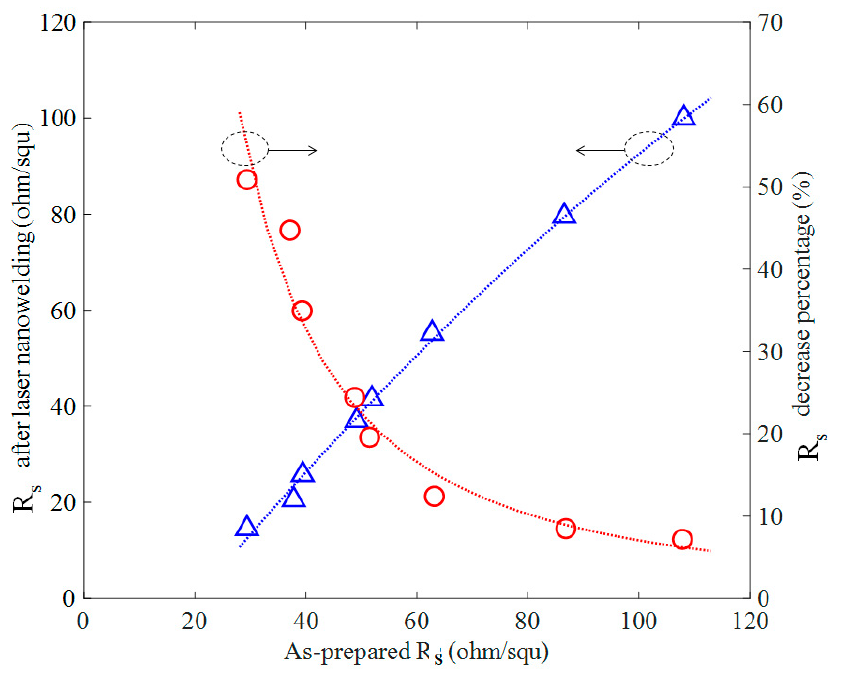
Figure 4. Sheet resistance after the laser nanowelding (left axis) and R s decrease percentage (right axis) as function of the as-prepared R s .